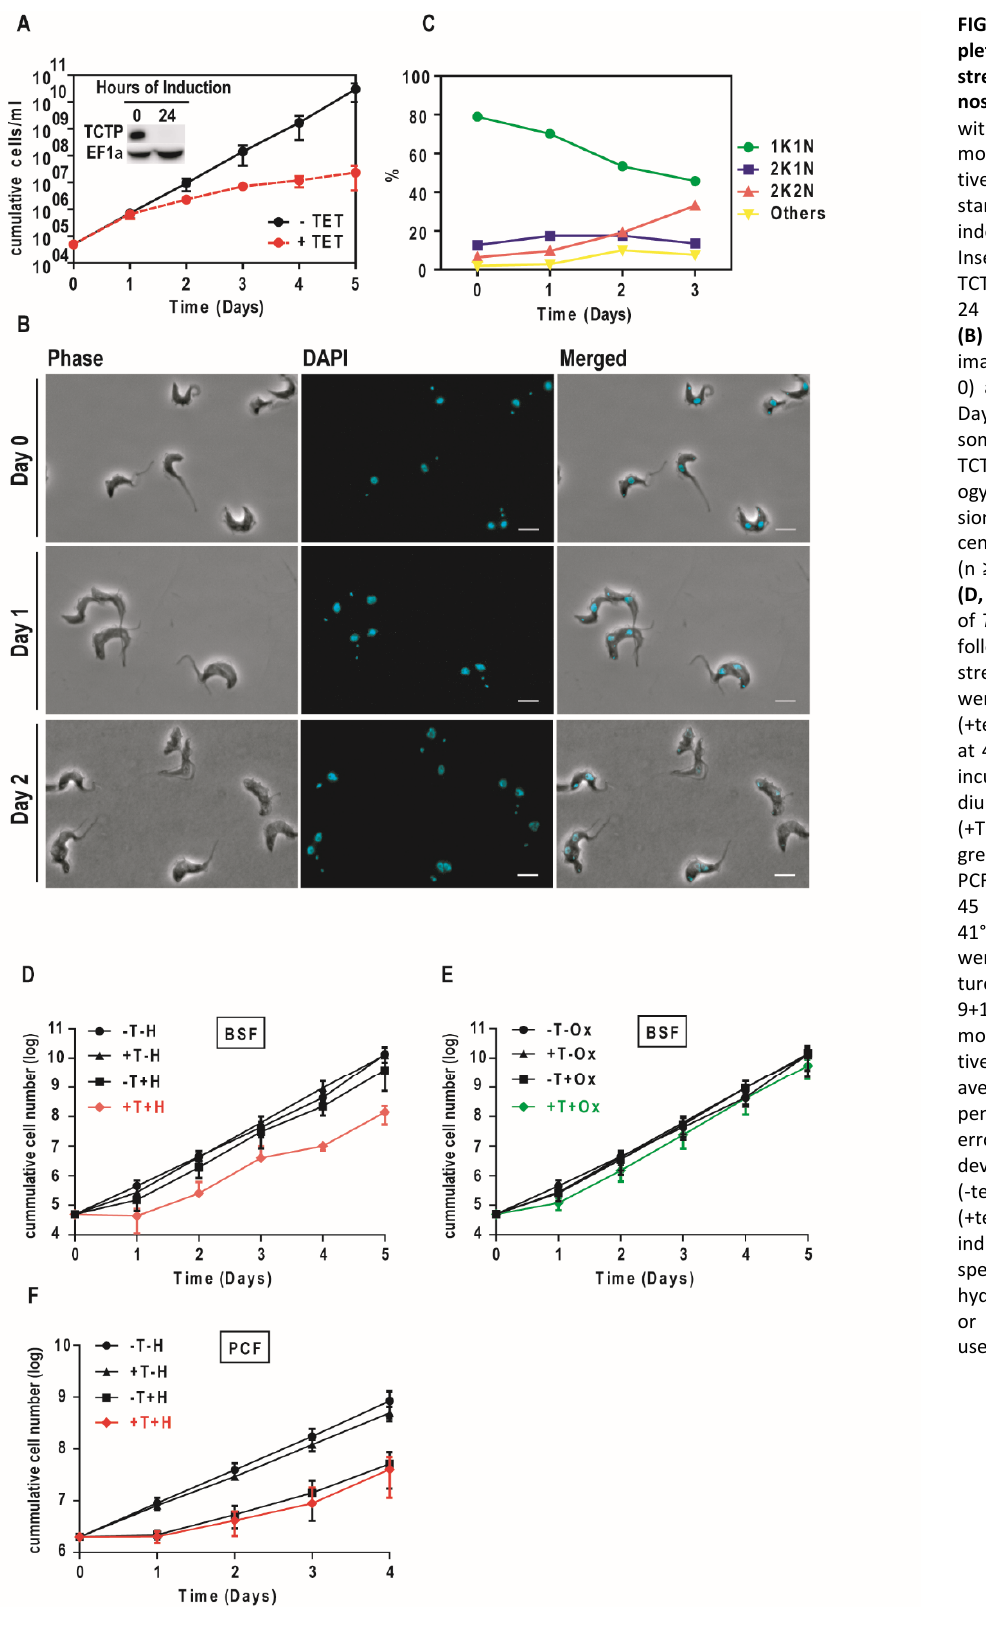
FIGURE 2: Effect of TCTP de- pletion, heat and oxidative stress in bloodstream trypa- nosomes. (A) Growth of cells with or without tet was monitored for five consecu- tive days. Bars represent standard deviation of four independent experiments. Inset: western blot